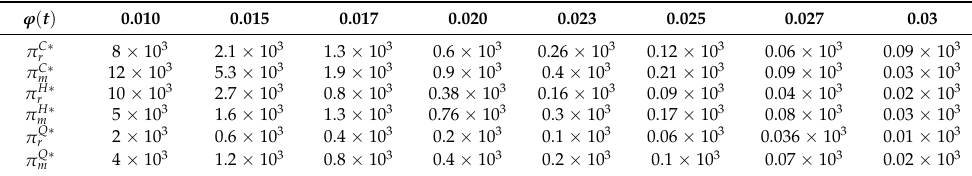
Table 2. Benefit changes with the effective output factor function ϕ ( t ) .